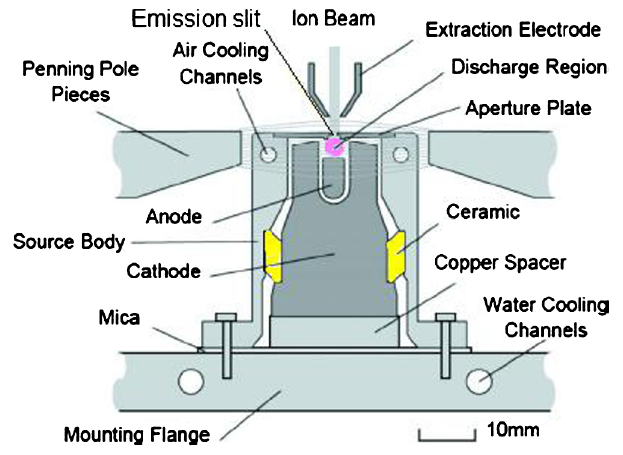
FIG. 3. Schematic of RAL ISIS version of Penning discharge SPS